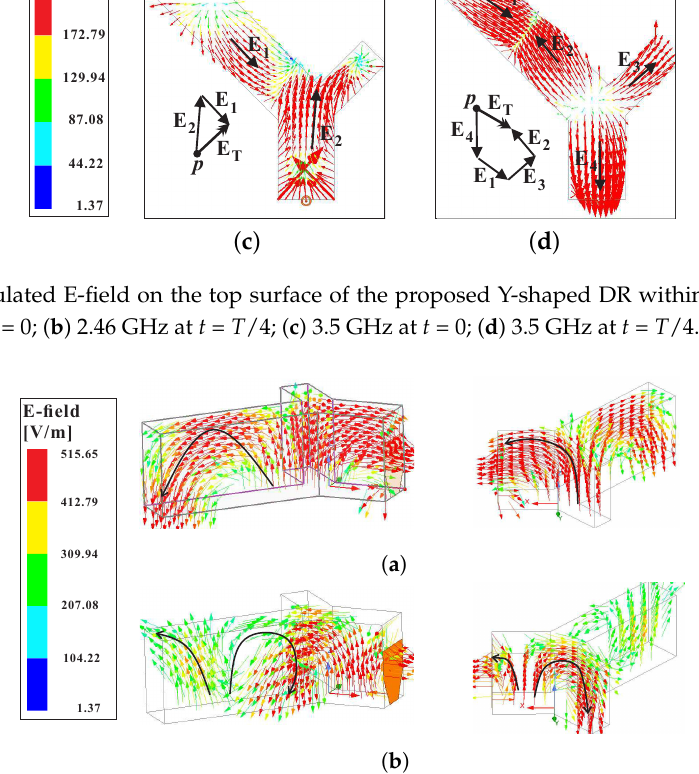
Figure 4. Mode distributions inside the proposed Y-shaped DR at the CP bands: ( a ) Quasi-TE 111 at 2.46 GHz ; ( b ) Quasi-TE 211 at 3.5